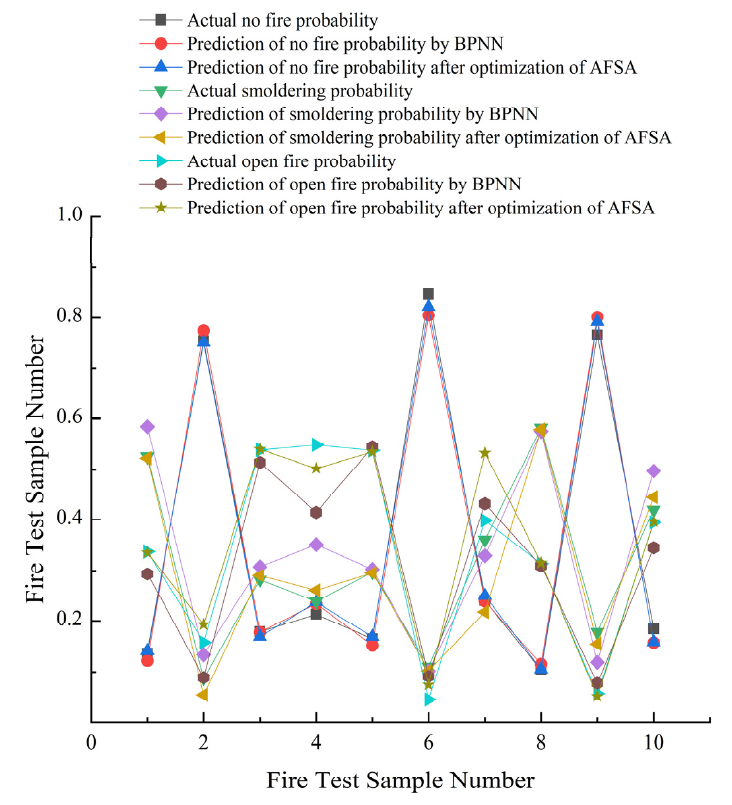
Figure 5. Forecast of fire